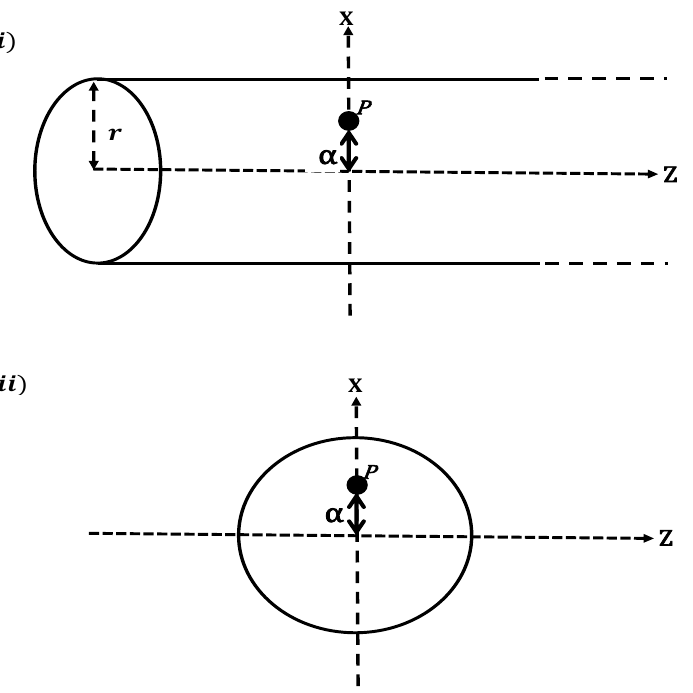
Figure 2. Schematic geometry for DOX an atniviral compound as two-connected spheres interacting: ( i ) with an interior atom inside a SWCNT of radius r at point P off-setting from the central-axis by a distance α and ( ii ) with an interior atom inside a fullerne derivative (C N -(OH) β ) of radius r s at point P off-setting from the central-axis by a distance α